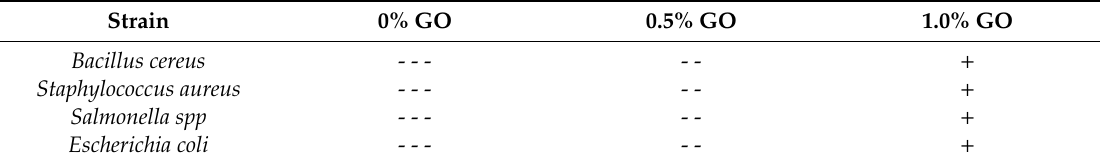
Table 1. Inhibition of electrospun CS / PVA / GO composite nanofibrous membranes against bacterial strains. Strain 0% GO 0.5% GO - - -